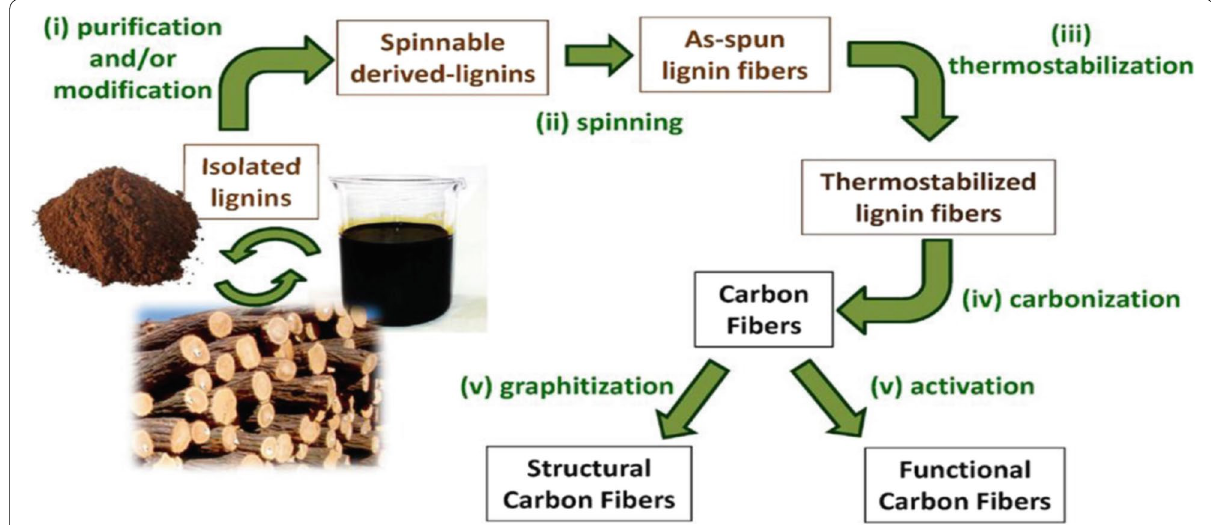
Fig. 9 Spinning of lignin into carbon fiber (Gbenebor and Adeosun